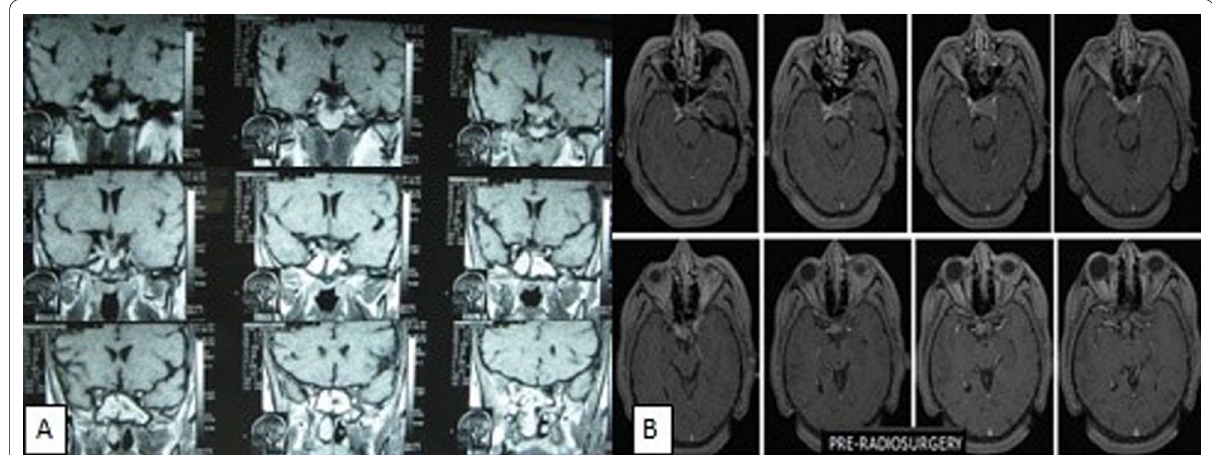
Fig. 3 Case N° 2: MRI brain (coronal ( A ) and axial cuts ( B )): pre-GK radiosurgery